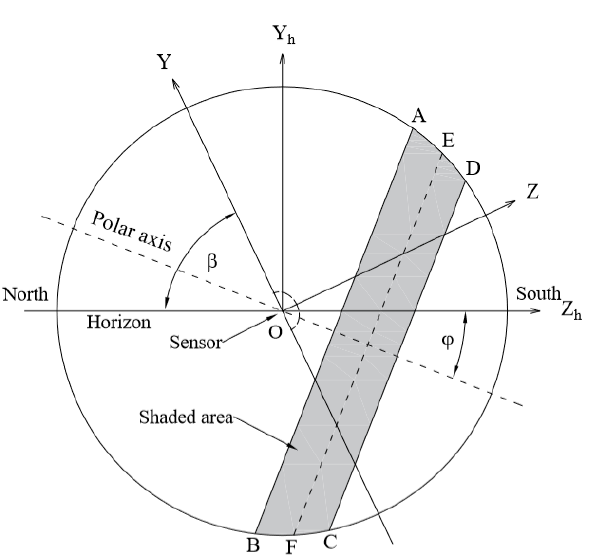
Figure 5. Spherical area shaded by a shadow band and projected on the plane Y (cid:2918) OZ (cid:2918) while 𝑑 (cid:3039) ≥ 0 .